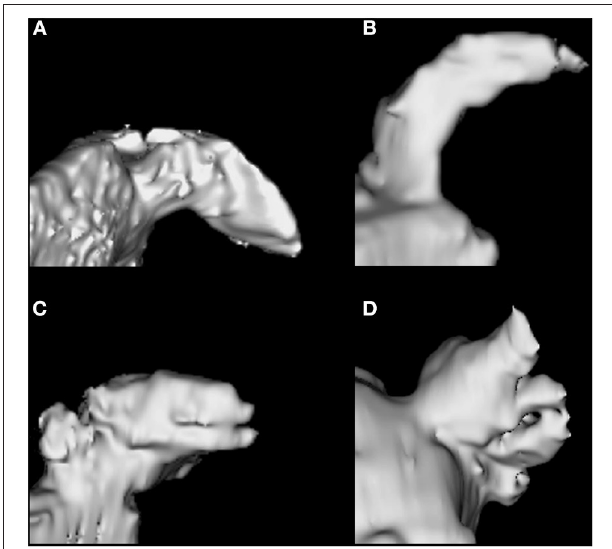
TABLE 1 | Baseline demographics and clinical characteristics.